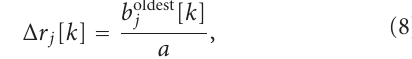
be negative. Therefore the modulus (or absolute value) of this required rate can be seen as the “distance” that the average data rate of a flow ( r j [ k ]) is from the average data rate requirement ( r req j